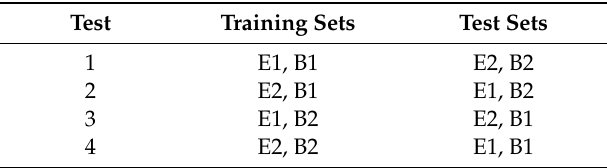
Table 1. Datasets for the four groups of cross validation.